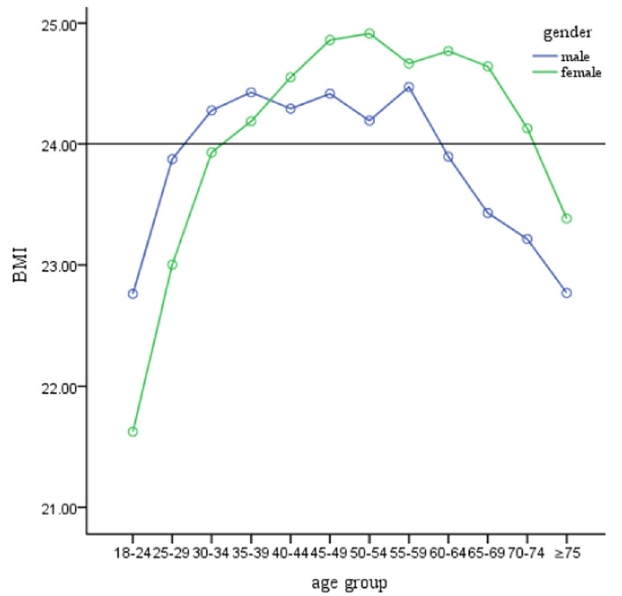
Figure 1. BMI prevalence in northwest China, by age and